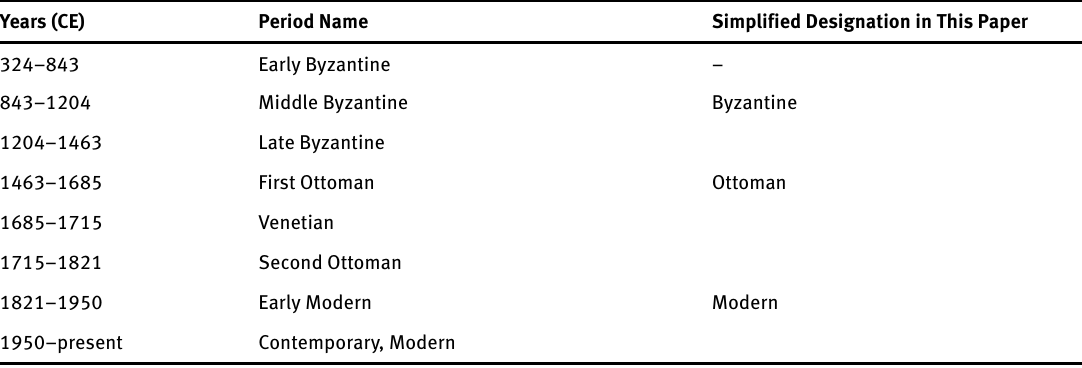
Table 1. Chronological Periods in the Peloponnese,